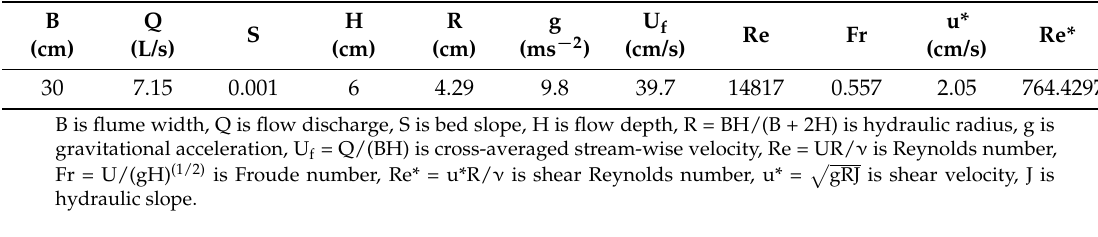
Table 1. Hydraulic and geometric conditions.